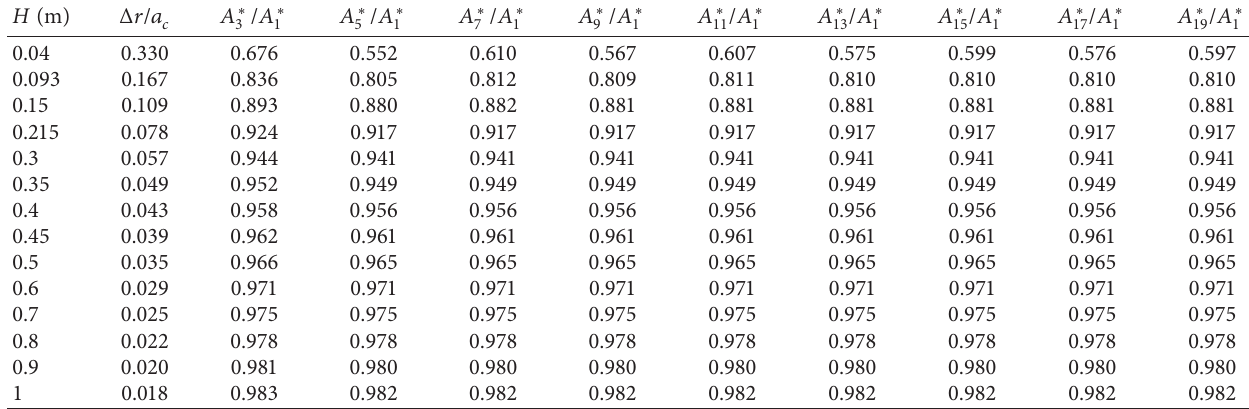
K ) calculated by modified maximum tangential stress (MMTS) criterion. if / Ic